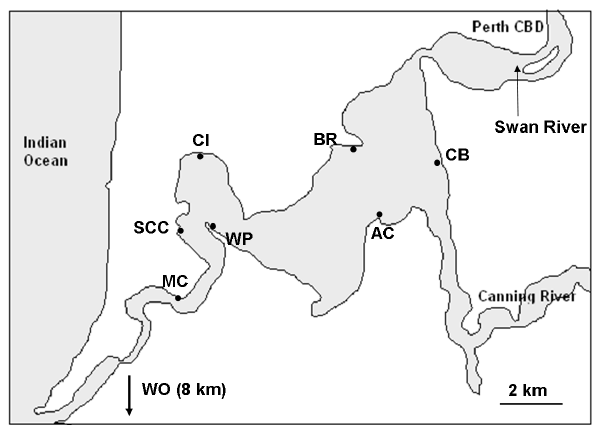
Figure 1. Map indicating the seven sampling sites (jetties) within the lower Swan River estuary, Perth, Western Australia. AC: Apple- cross, BRD: Broadway, CB: Como Beach, Cl: Claremont (Fresh- water Bay), MC: Minim Cove, SCC: Swan River Canoe Club, WP: Point Walter; the ocean reference site was located 8km south of the estuary mouth (WO: Woodman